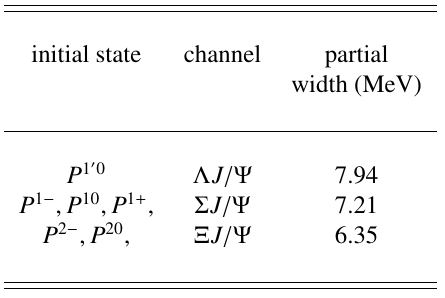
Table 1. Partial decay widths for Λ J / Ψ , Σ J / Ψ and Ξ J / Ψ channels, calculated from the constraint that J / Ψ p channel accounts for the 5% of the total pentaquark width, according to